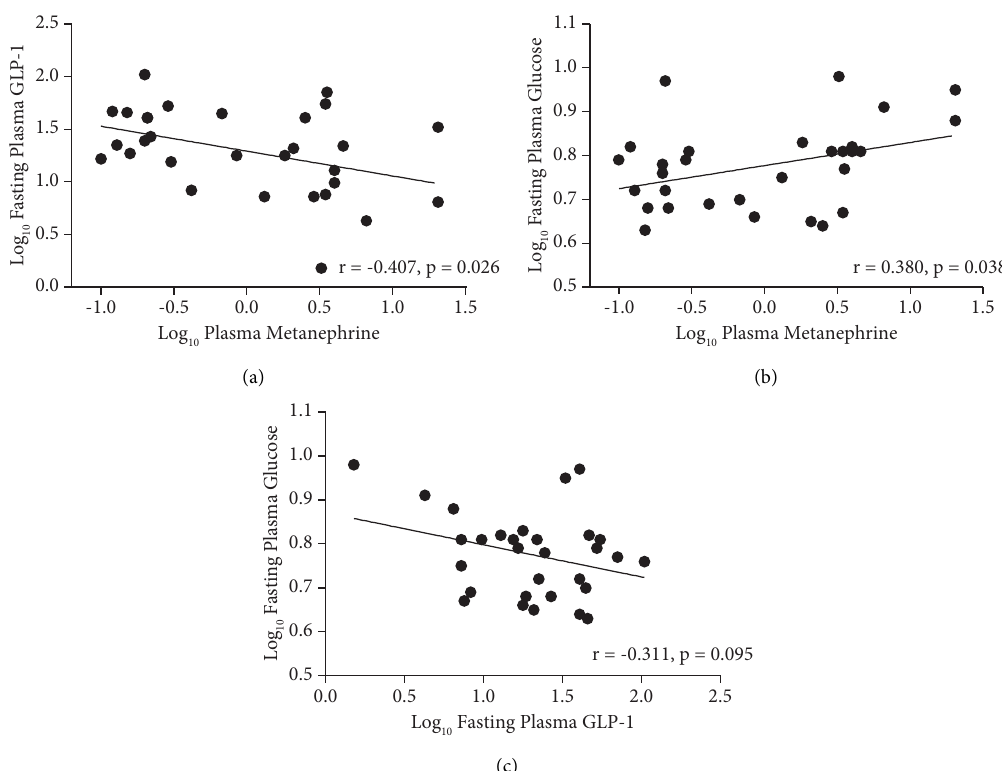
Figure 1: Pearson’s correlation analysis among fasting plasma GLP-1, plasma MN, and plasma glucose levels. (a) Association between plasma metanephrine and fasting plasma GLP-1. (b) Association between plasma metanephrine and fasting plasma glucose. (c) Association between fasting plasma GLP-1 and fasting plasma glucose. Data were logarithmically transformed to approximate a normal distribution. Table 2: Multiple linear regression analyses for the association of plasma GLP-1 levels with plasma-free MN. Regression analysis Unadjusted coefcient β